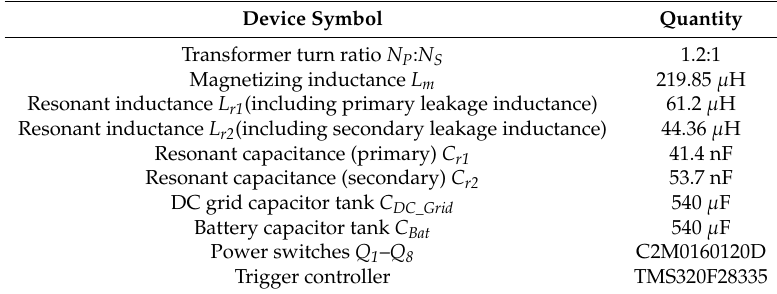
Table 2. Selected parameters of the important